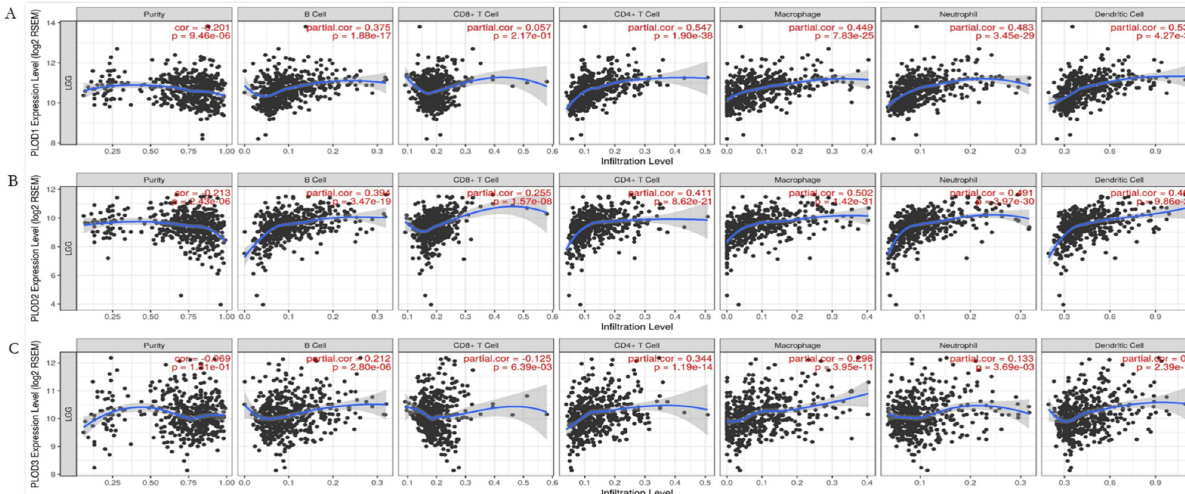
Fig 6. Correlations of PLODs expression with immune infiltration level in LGG. (A) The correlation between each type of TIICs (B-cells, CD4+ T- cells, CD8+ T-cells, neutrophils, macrophages and dendritic cells) and PLOD1. (B) The correlation between each type of TIICs (B-cells, CD4+ T-cells, CD8+ T-cells, neutrophils, macrophages and dendritic cells) and PLOD2. (C) The correlation between each type of TIICs (B-cells, CD4+ T-cells, CD8 + T-cells, neutrophils, macrophages and dendritic cells) and